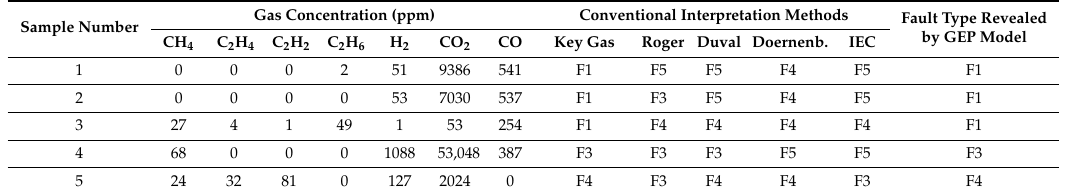
Table 9. DGA samples with the five conventional interpretation techniques and the developed GEP